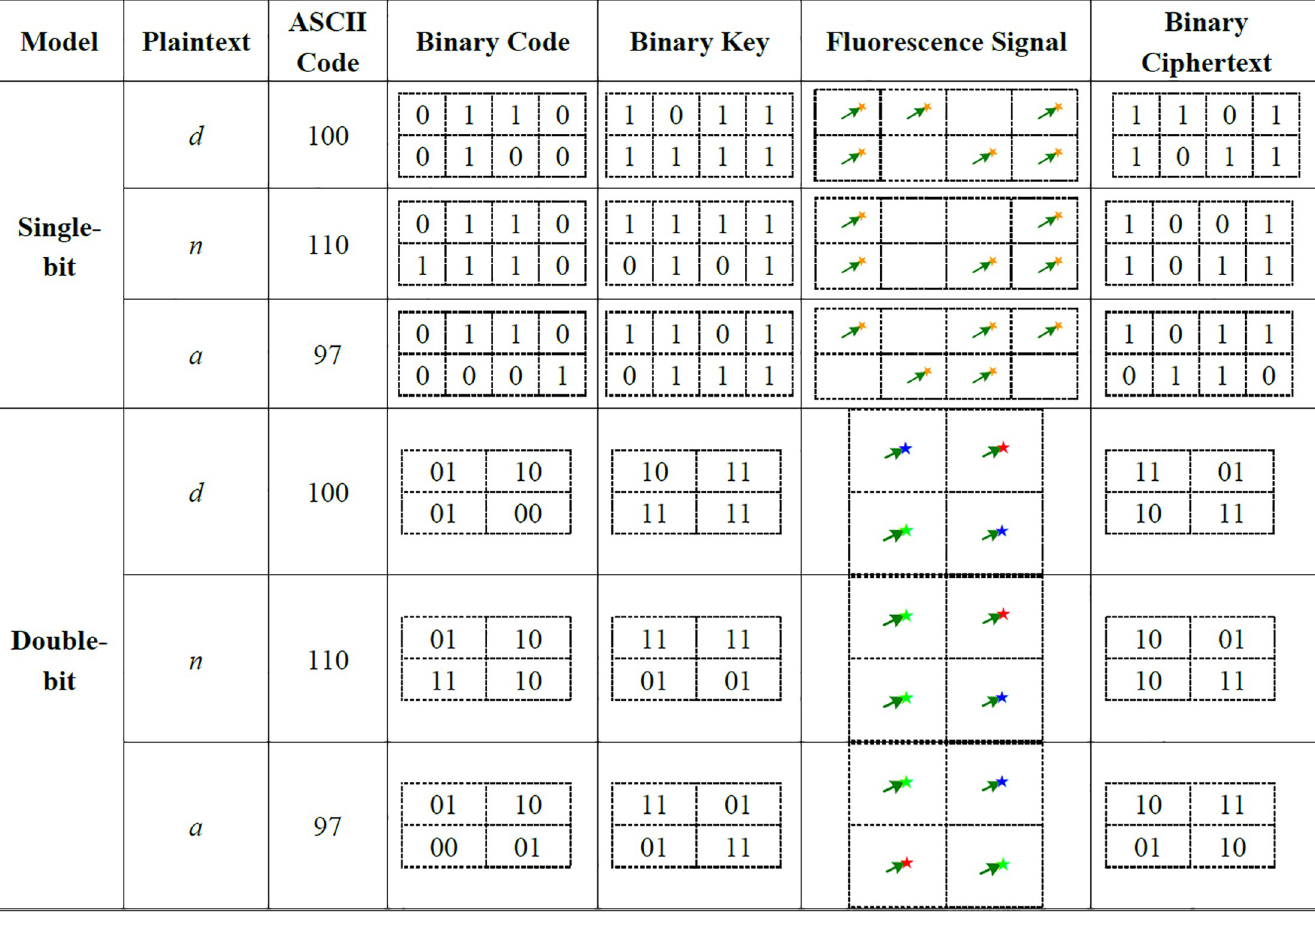
Fig 6. The process of encryption by using two